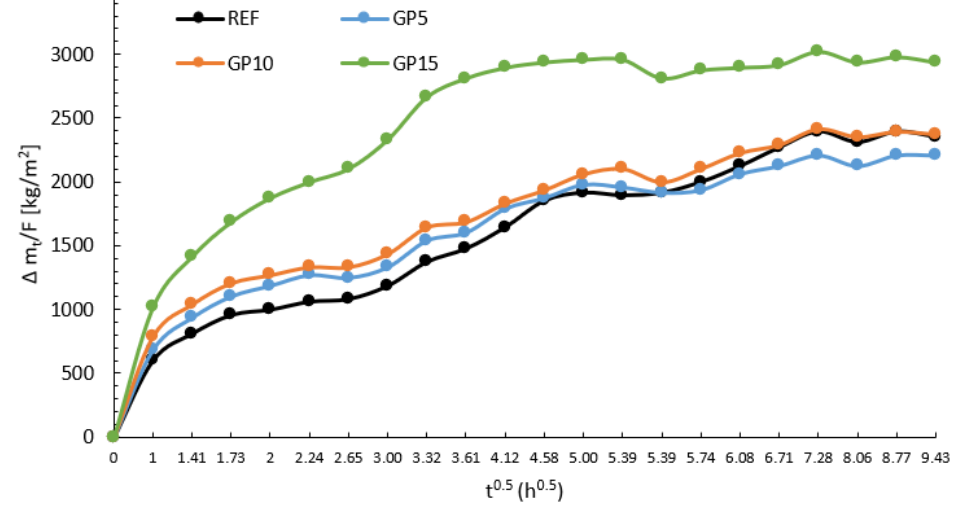
Figure 5. Diagram of ∆ mt/F as a function of time root t 0.5 for the series with the partial replacement of cement with granite powder and the reference series